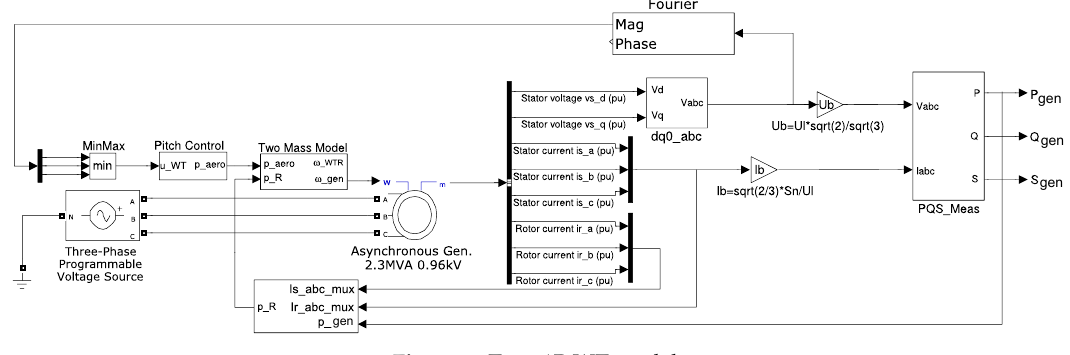
Figure 9. Type 1B WT model.